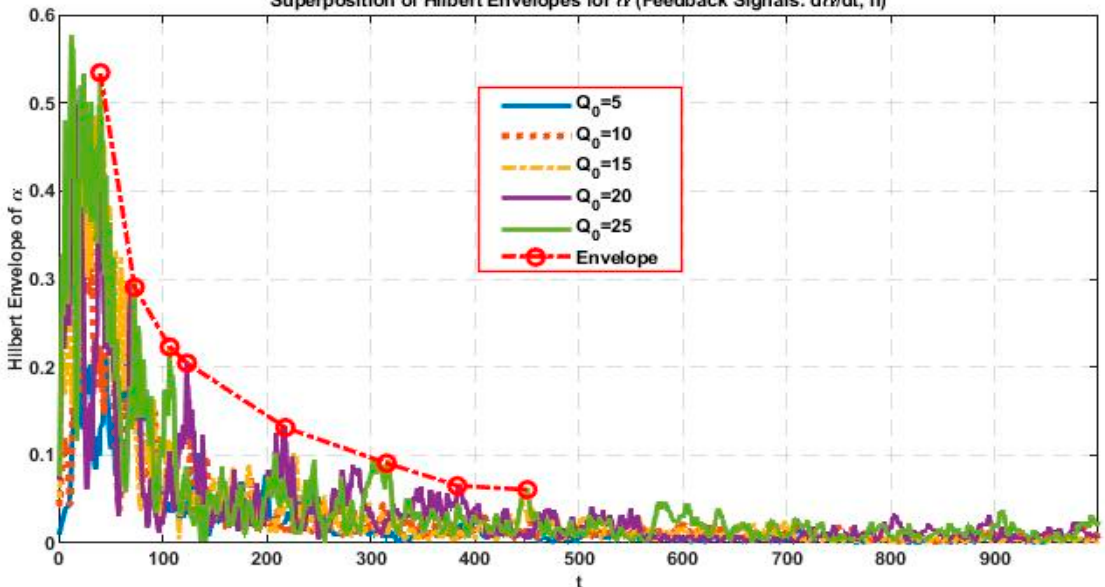
Figure 23. Amplitude function for different values of Q o.